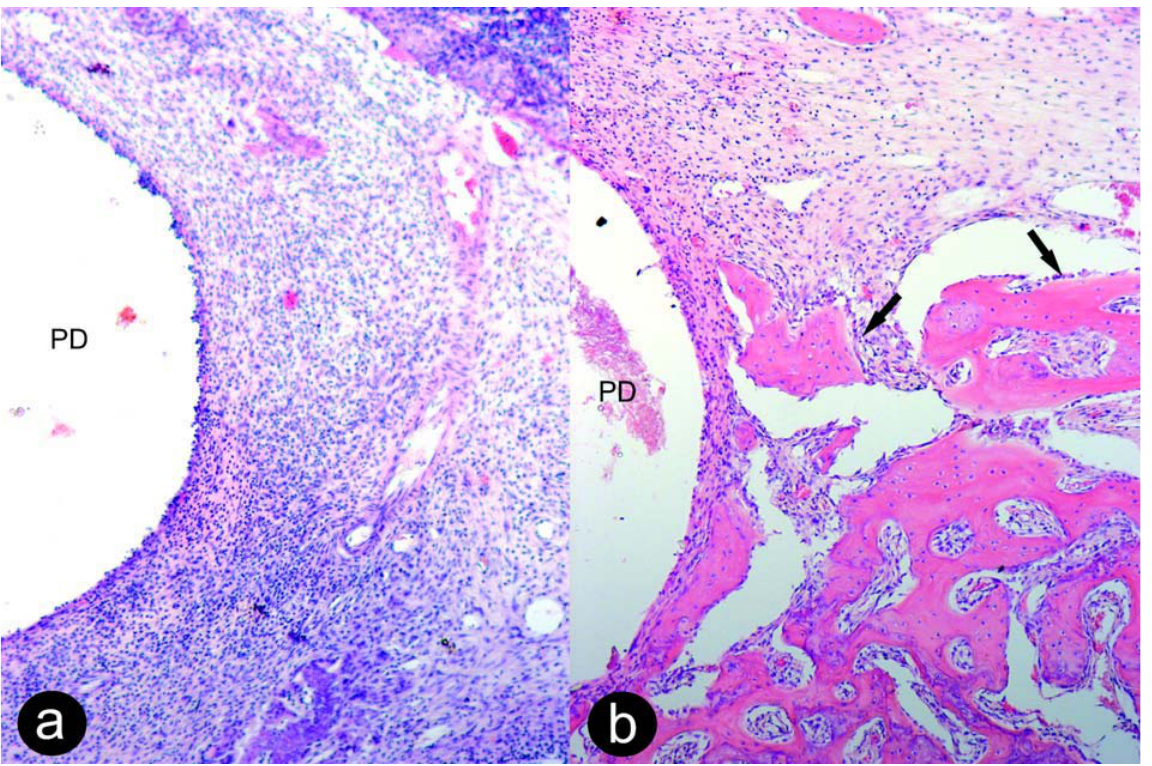
FIGURE 3- This image shows the behavior of Group II at 7 days (a) and 28 days (b) close to the periodontal dressing (PD). The arrows indicate bone tissue formation. HE, original magnification 100X